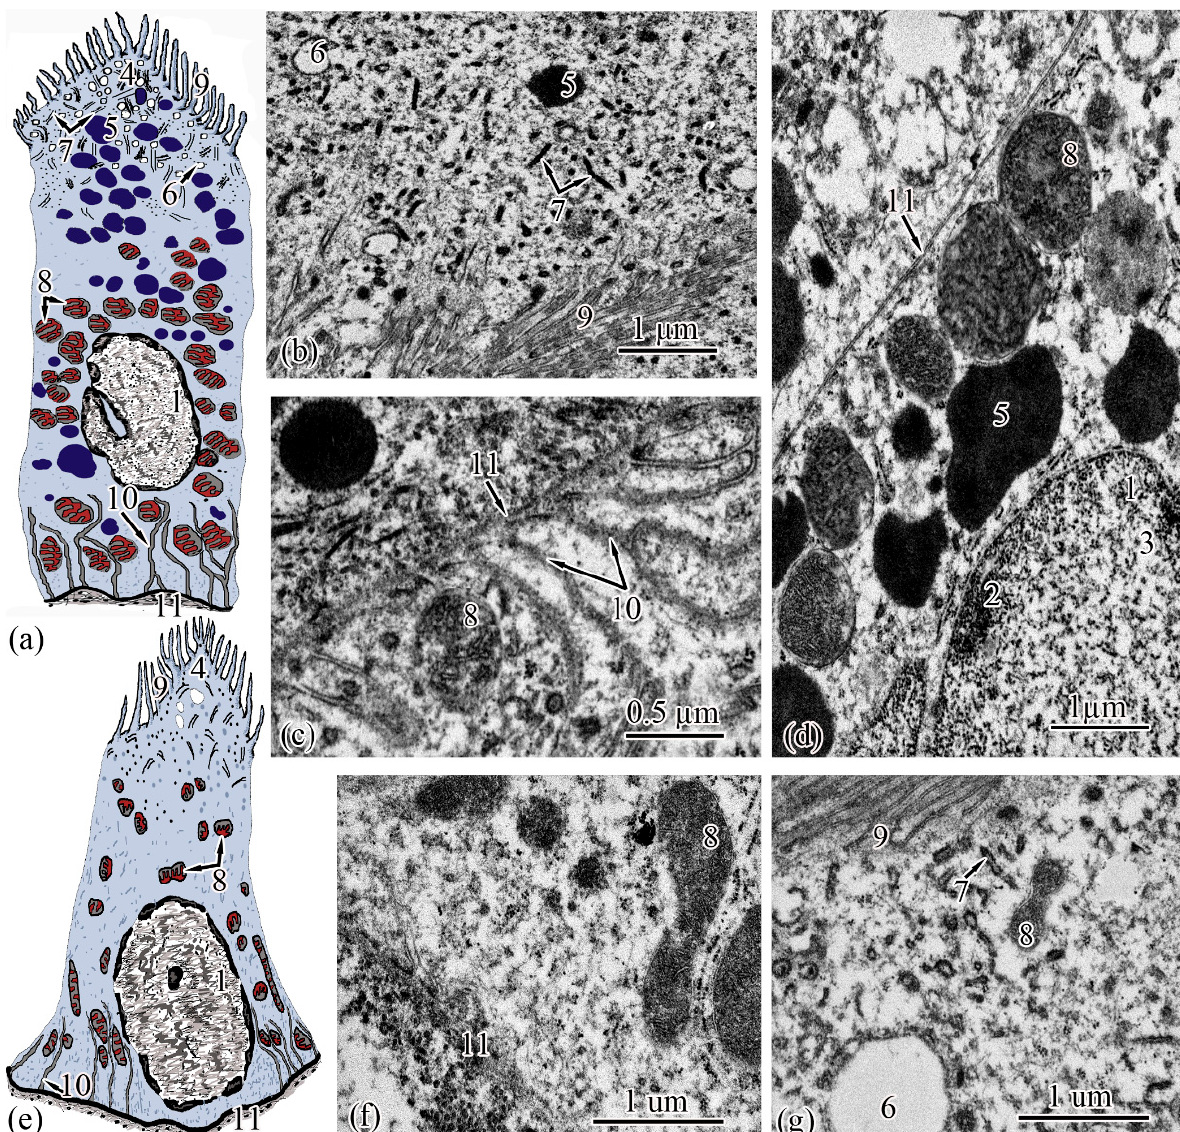
Figure 4. Ultrastructure of the proximal tubule. Type I epithelial cell scheme ( a ); endocytosis zone and a portion of the brush border of type I epithelial cell of the proximal tubule ( b ); basal part of type I epithelial cell of the proximal tubule ( c ); apical part of type I epithelial cell of the proximal tubule ( d ); type II epithelial cell scheme ( e ); basal part of type II epithelial cell of the proximal tubule ( f ); apical part of type II epithelial cell of the proximal tubule ( g ). Cell units: nucleus (1), heterochromatin (2), euchromatin (3), endocytosis zone (4), secretory granules (5), vesicle (6), tubular endoplasmic reticulum (7), mitochondria (8), microvilli (9), smooth endoplasmic reticulum (10), basement membrane (11).